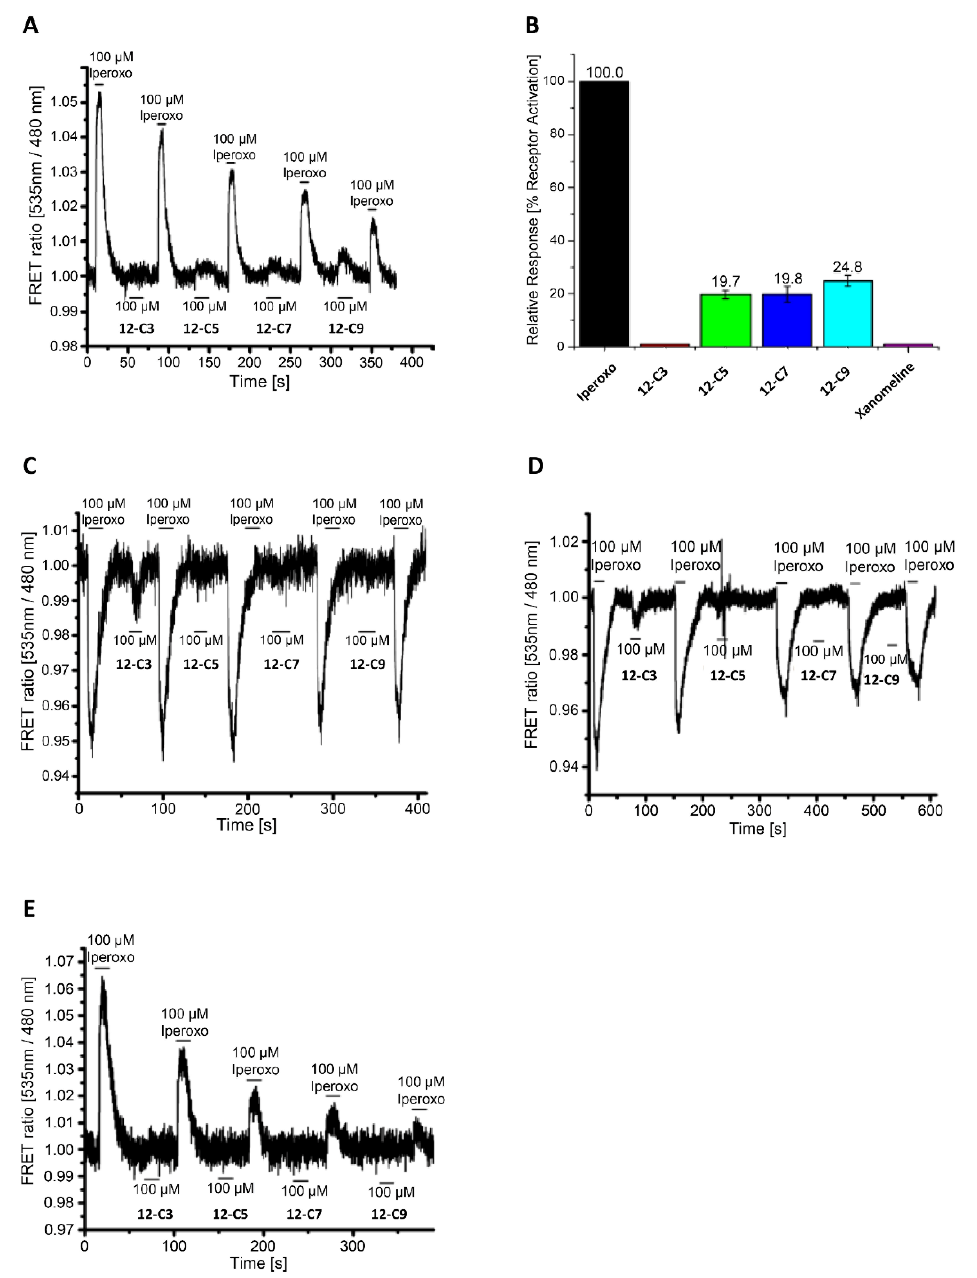
Figure 4. Evaluation of the Xanomeline/77-LH-28-1 hybrid ligands 12-Cn at the M 1 ( A ); M 2 ( C ); M 4 ( D ); and M 5 ( E ) muscarinic FRET receptor sensors stably expressed in HEK293 cells. One hundred micromolar Iperoxos ( 2 ) were used as a reference ligand throughout the recording, as indicated by black bars above the recorded signals. One hundred micromolar concentrations of the hybrid compounds 12-C3 , 12-C5 , 12-C7 , and 12-C9 were applied as indicated at the appropriate time points by black bars below the recorded signal; ( B ) quantified maximal ligand-induced FRET response of compounds 12-Cn as a percent of control (100 μM Iperoxo) at the M 1 receptor sensor. Each bar represents the average of at least 10 independent measurements.